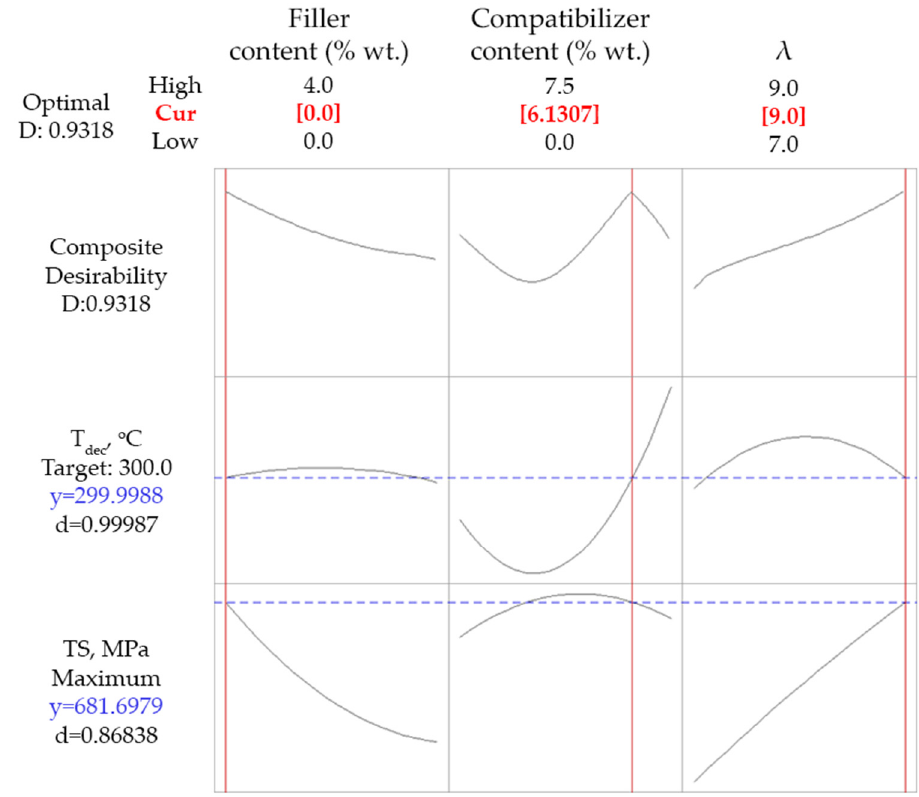
Figure 4. Optimization results targeting maximum TS and T dec at least equal to 300 ◦ C for composites with talc.